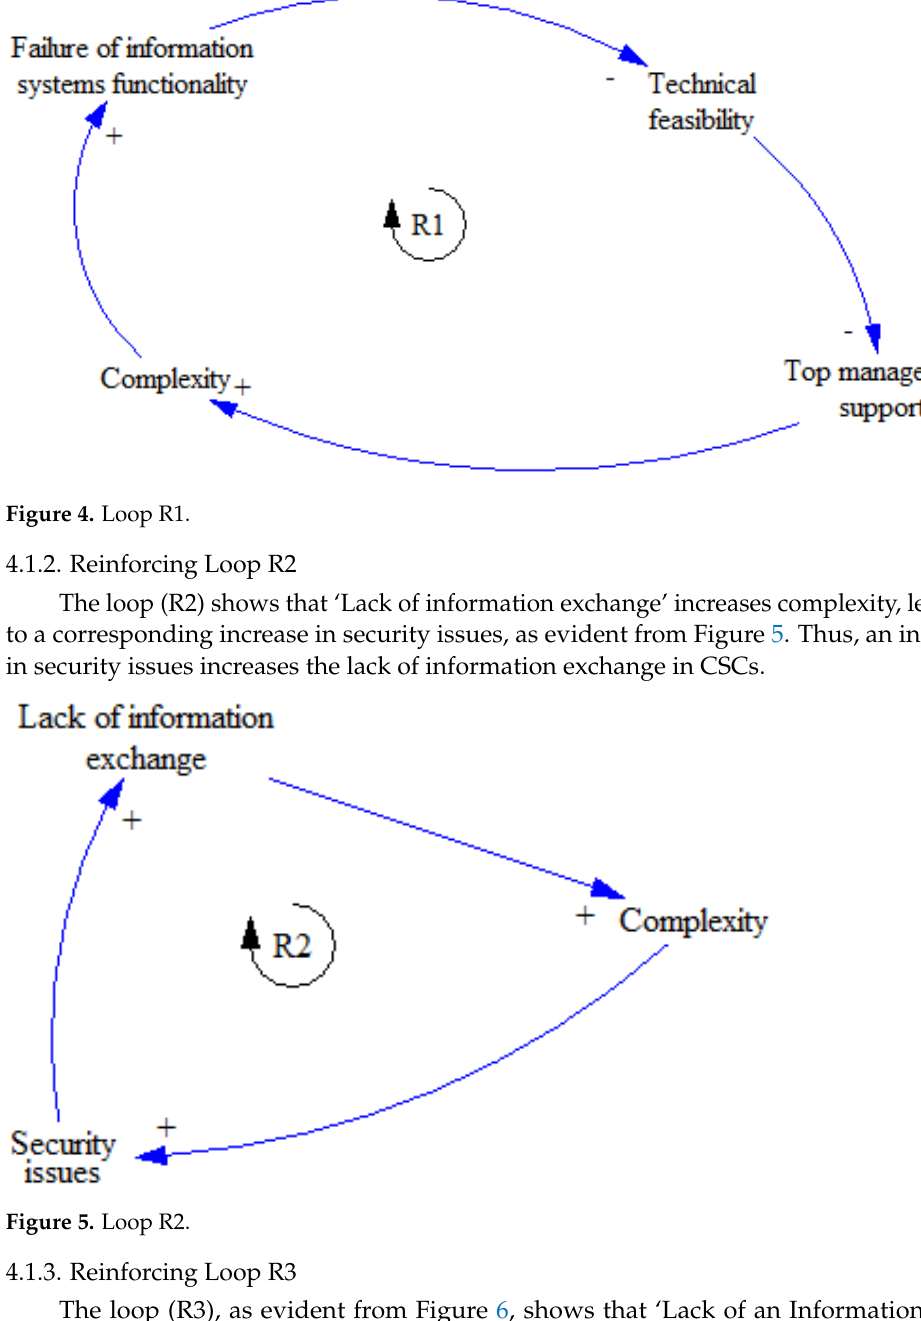
13 of 24 Figure 3. Causal loop diagram. 4.1.1. Reinforcing Loop R1